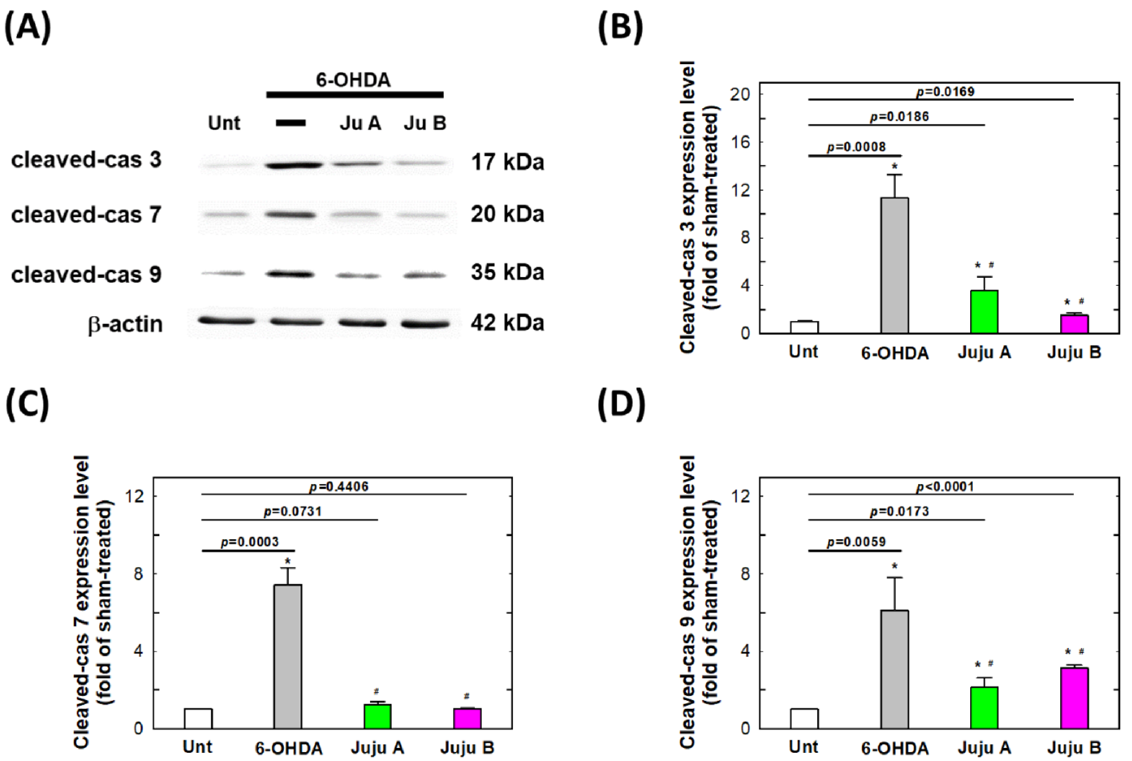
Figure 12. The signaling patterns altered by the treatments of 6-OHDA and jujubosides. ( A ) Western blotting was conducted specifically for cleaved caspase-3, cleaved caspase-7 and cleaved caspase-9. ( B ) Quantitative analysis of the intensities of cleaved-caspase 3 bands. ( C ) Quantitative analysis of the intensities of cleaved-caspase 7 bands. ( D ) Quantitative analysis of the intensities of cleaved-caspase 9 bands. β-actin was served as an internal loading control in each repeat of experiment. * significant different from untreated group. # significant different from the 6-OHDA treated group.